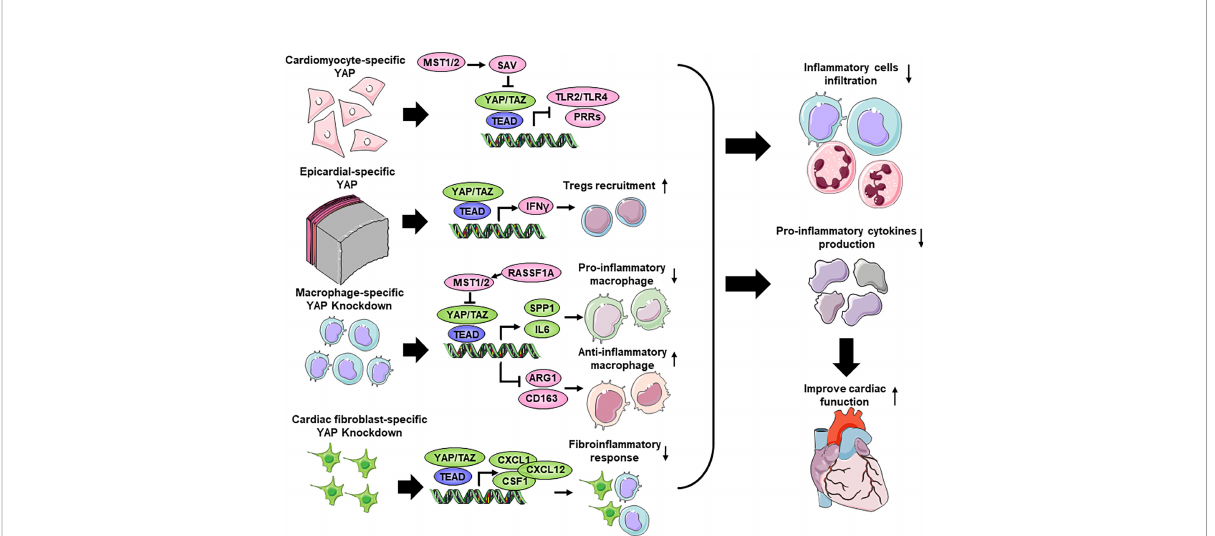
FIGURE 2 Cell type-dependent Hippo-YAP pathway regulate the in fl ammation response after Myocardial infarction. Cardiomyocyte-speci fi c YAP inhibits in fl ammatory cells in fi ltration, including macrophages and neutrophils, and pro-in fl ammatory cytokines production through interacting with TLRs (toll-like receptors), thus improve cardiac function. Epicardial-speci fi c YAP increases Tregs (T-regulatory cells) recruitment to inhibit macrophage in fi ltration and pro-in fl ammatory cytokines production through affecting IFN- g (interferon g ) expression. Macrophage-speci fi c knockdown of YAP decreases the accumulation of pro-in fl ammatory macrophages and enhances the accumulation of anti-in fl ammatory macrophages through regulating the expression of Spp1 (secreted phosphoprotein 1), IL6 (interleukin 6), ARG1 (arginase 1), CD163 to improve cardiac function. Cardiac fi broblast-speci fi c knockdown of YAP inhibits fi broin fl ammatory response to decrease the recruitment of in fl ammatory cells, the production of pro-in fl ammatory cytokines and improve heart function. CSF1, colony stimulating factor 1; CXCL1, C-X-C Motif Chemokine Ligand 1; CXCL12, C-X-C Motif Chemokine Ligand 12; PRRs, pattern recognition